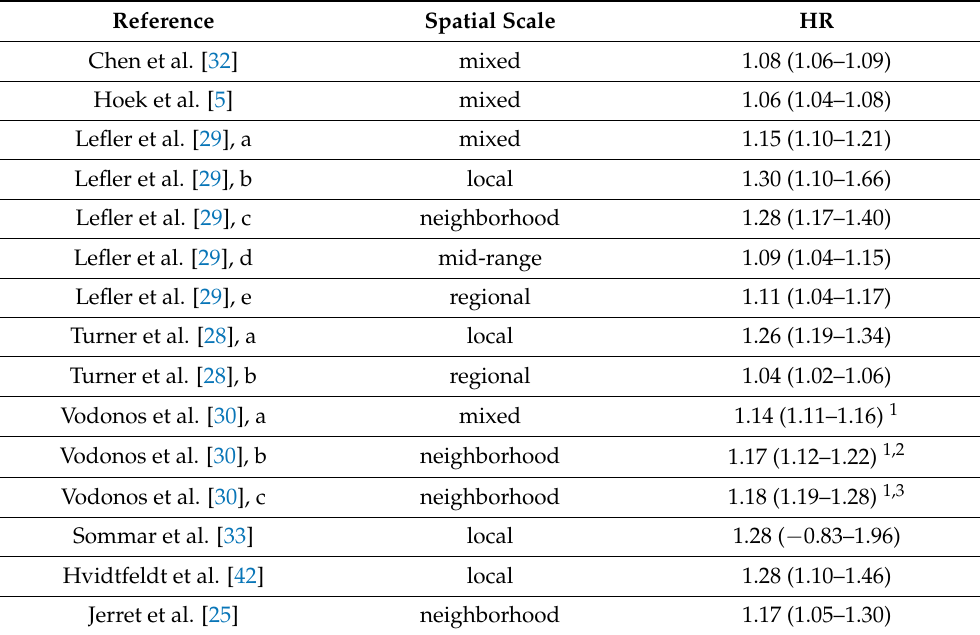
Table A1. HR for all-cause mortality per 10 µ gm − 3 PM 2.5 categorized according to spatial resolution of the exposure data. “Local scale” represents spatial resolution <1 km, “neighborhood” 1–10 km, mid-range 10–100 km, and “regional” >100